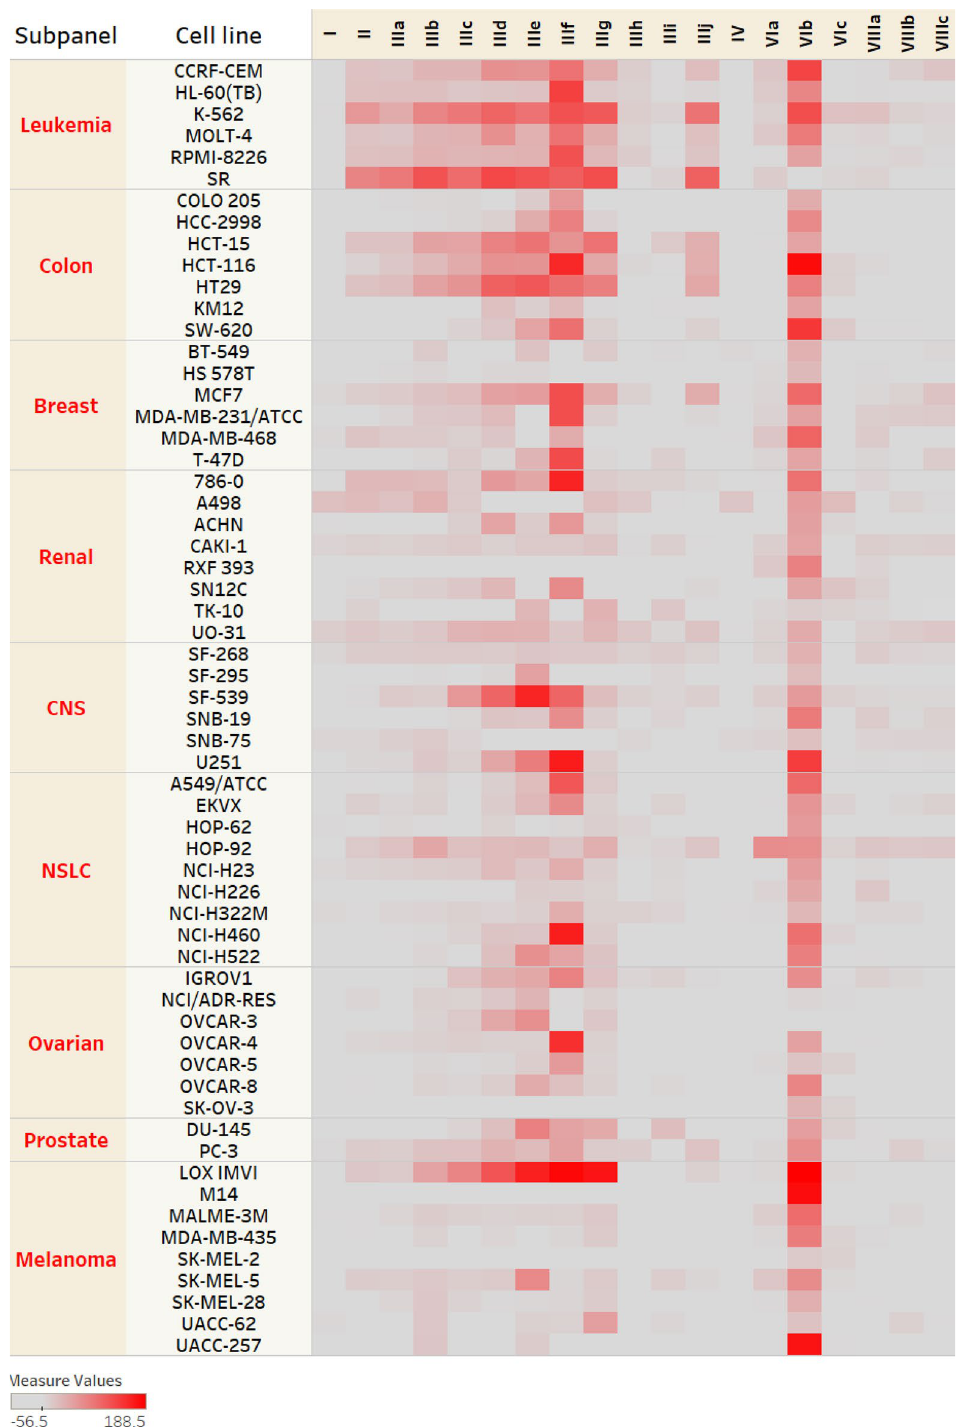
Figure 8. Heat map of the mean growth inhibition % of the tested derivatives in the single dose NCI-60 Human Tumor Cell Lines Screen at 10 µM. Red color intensity corresponds to more potent growth inhibition. Generated using Tableau 2022.3. (2022). (https:// www. table au. com/ produ cts/ deskt op) 36